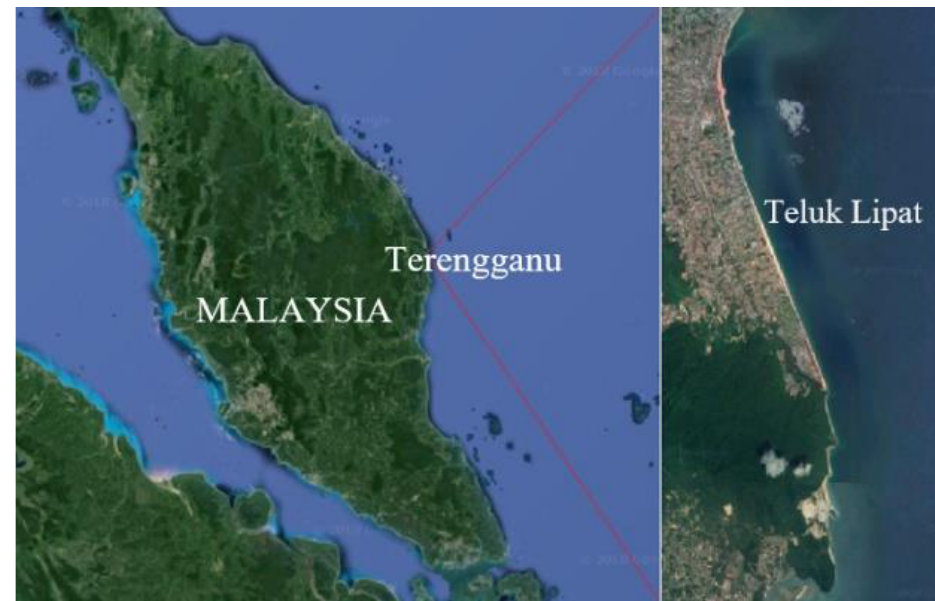
Figure 1. Study area.